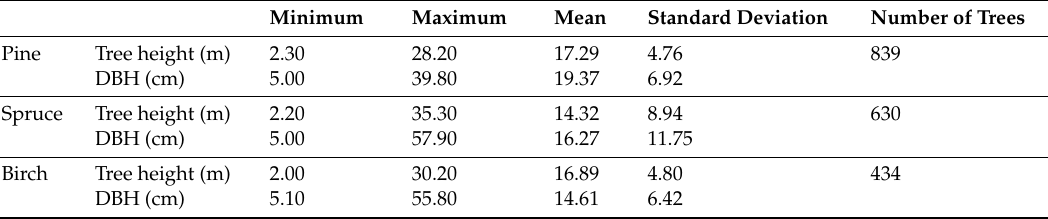
Table 2. The descriptive statistics of sample trees by tree species.